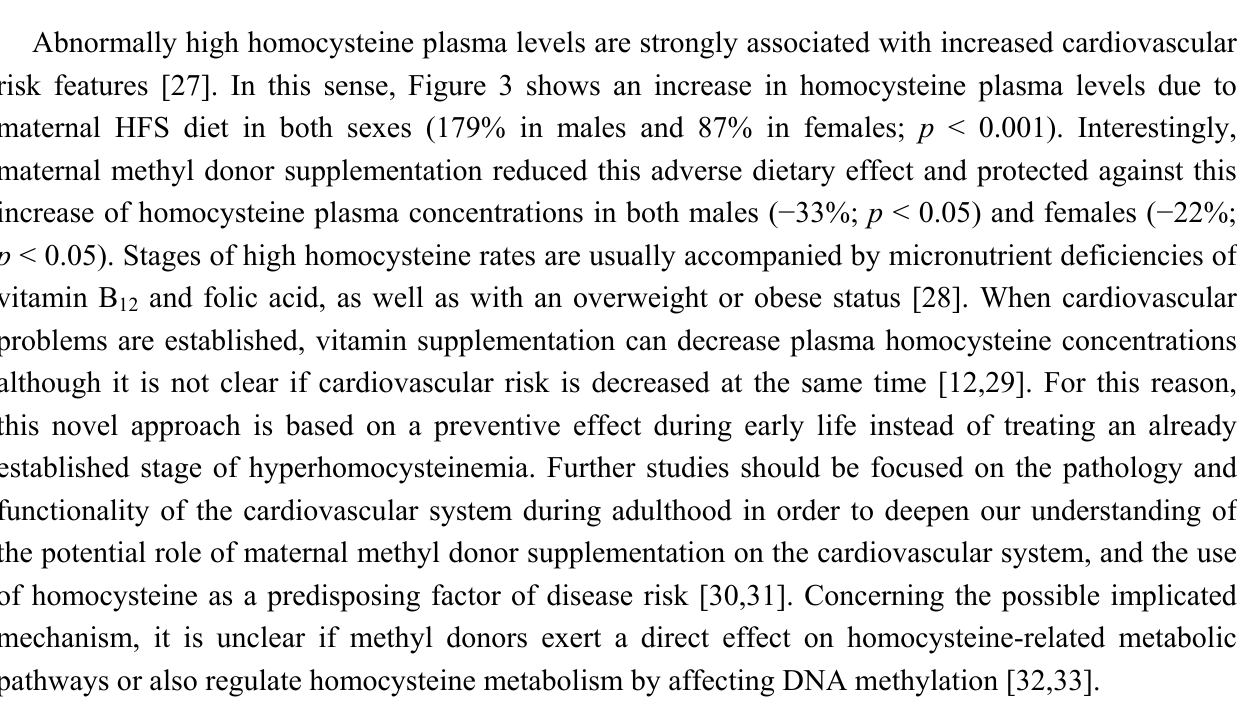
Figure 3. Homocysteine plasma concentration from male and female offspring depending on maternal nutrition during lactation. Data are reported as means ± SE ( n between 6 to 8 from each experimental group). C, control; C supp, control supplemented; HFS, high-fat-sucrose; HFS supp, high-fat-sucrose supplemented; different letters indicate differences between groups of at least